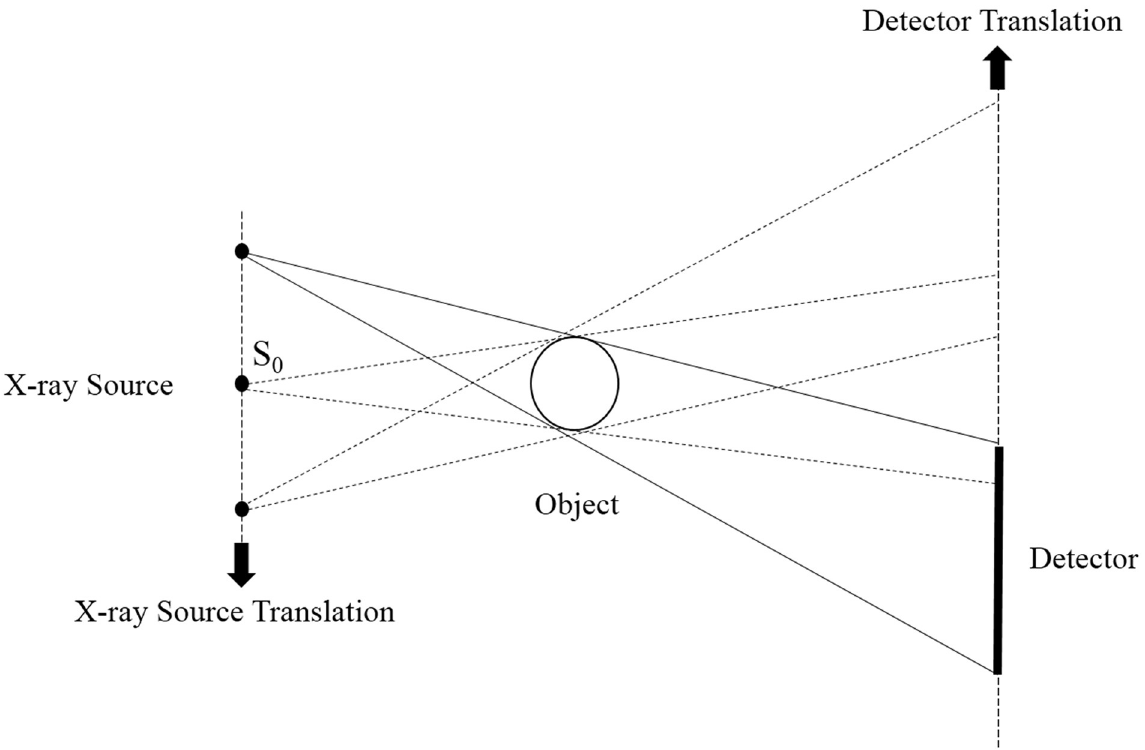
Fig 1. Translation based CT.